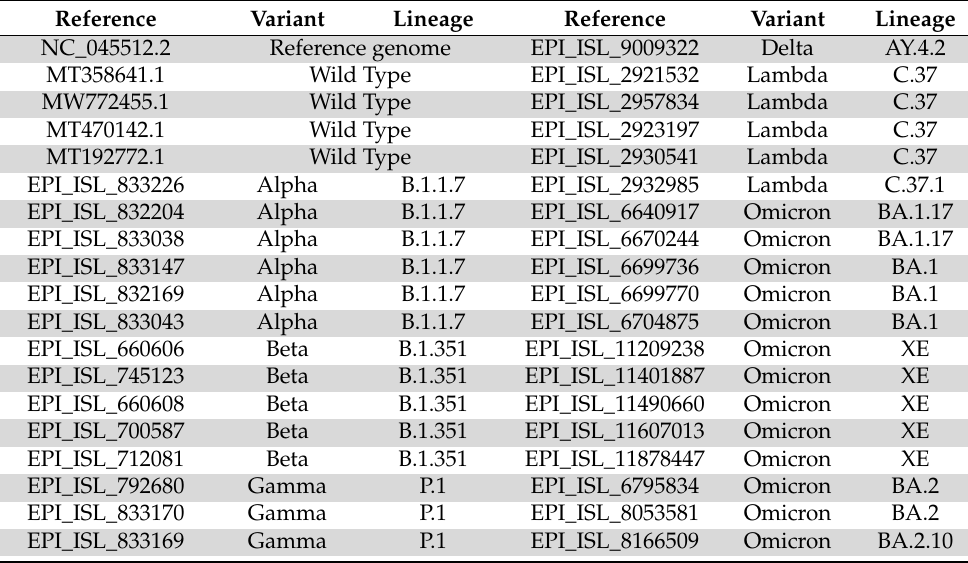
Table A2. The sequences included in the reference